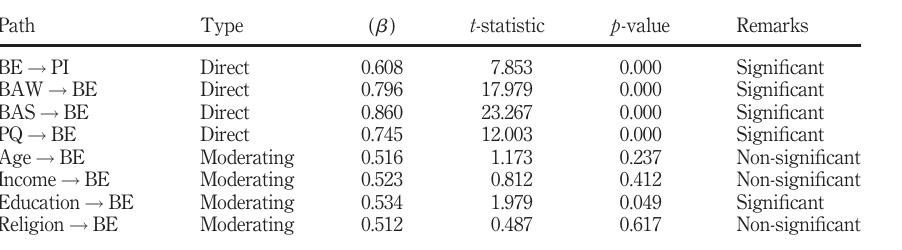
Table 4. Path coef fi